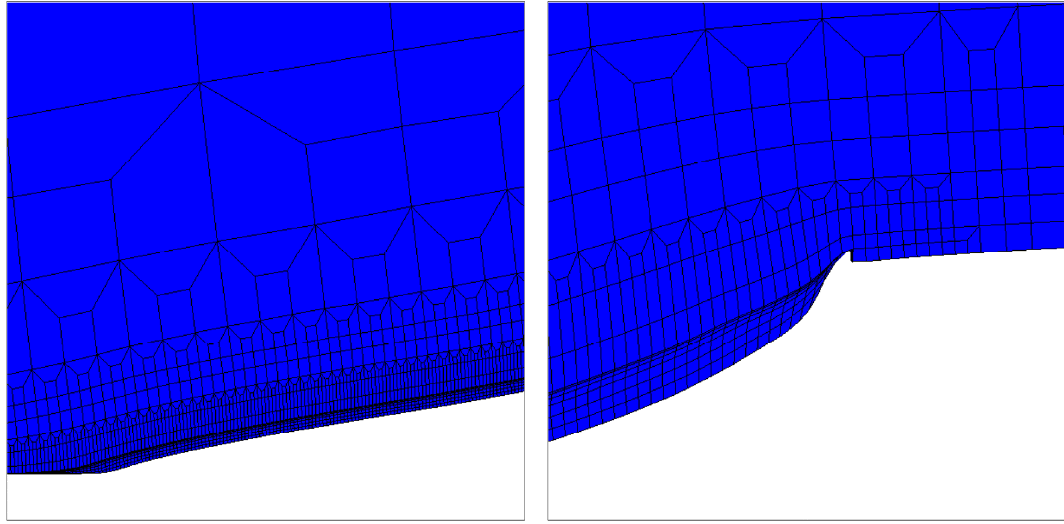
Figure 13: Deformed configuration near the crack tip and the initial crack